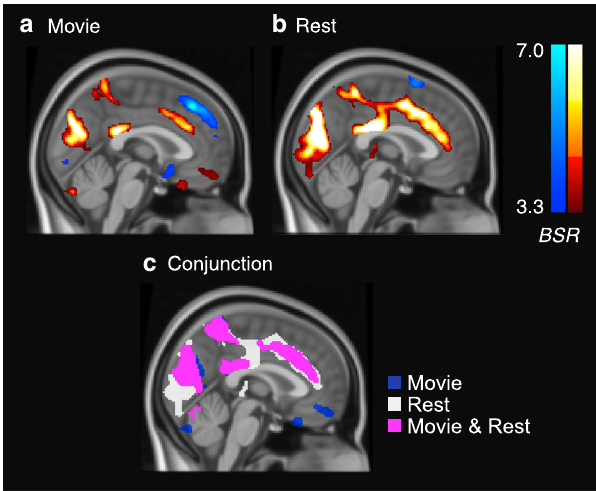
Fig. 4 Spontaneous thought and attention regions distinguish transitions from meta-stability. BOLD activity differences are quanti fi ed by the bootstrap ratio (BSR) statistic. The red scale represents transitions > meta- stability, whereas the blue scale represents meta-stability > transitions. a During movie-viewing fMRI, greater BOLD activity was observed during transitions than meta-stable timepoints, in several midline regions, including anterior cingulate cortex, posterior cingulate cortex, and visual association cortex. b During resting-state fMRI, greater BOLD activity was observed during transitions than meta-stable timepoints in similar midline regions. c Substantiating the subjective similarity of a and b , conjunction analysis revealed substantial voxel-wise overlap for regions activated during transitions (see Supplementary Tables 1 – 3 for voxel cluster details).